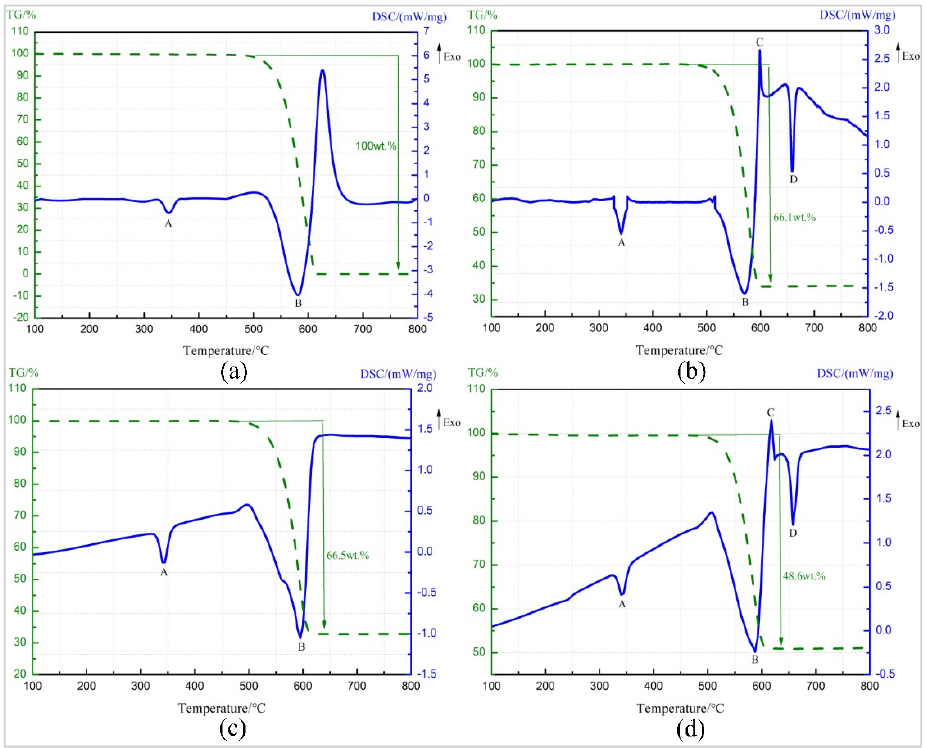
Figure 6. TG-DSC (Thermogravimetry-differential scanning calorimetry) curve of four materials. ( a ) Pure PTFE ( b ) Al/ PTFE ( c ) Ta/PTFE ( d ) Al/Ta/PTFE.